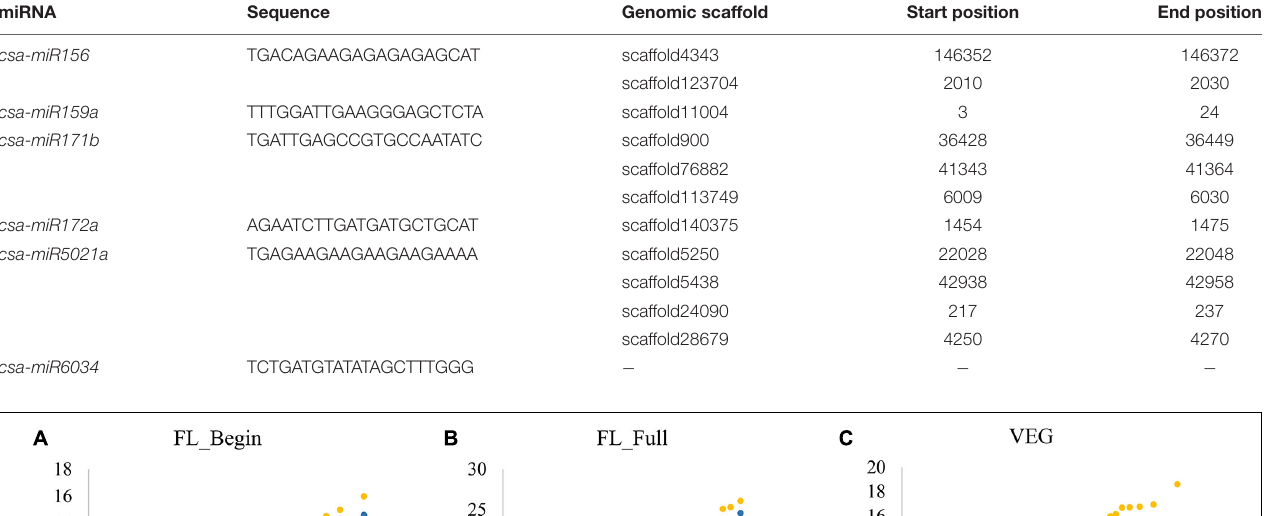
TABLE 1 | Nucleotide sequences of 6 miRNA in silico predicted and validated in Cannabis sativa by Das et al. (2015) and their positions in the cannabis genome (van Bakel et al., 2011). miRNA Sequence Genomic scaffold Start position